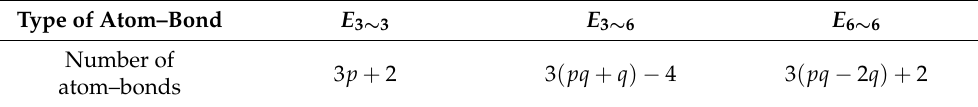
Table 1. Atom–bond partition of SC p q for p = q